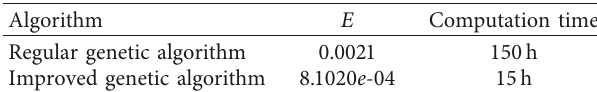
Figure 7: Simulation results: (a) objective function values for the optimal solutions at each iteration; (b) result of CA mortar dis- engagement degree estimation. Table 4: Comparisons of error and computation